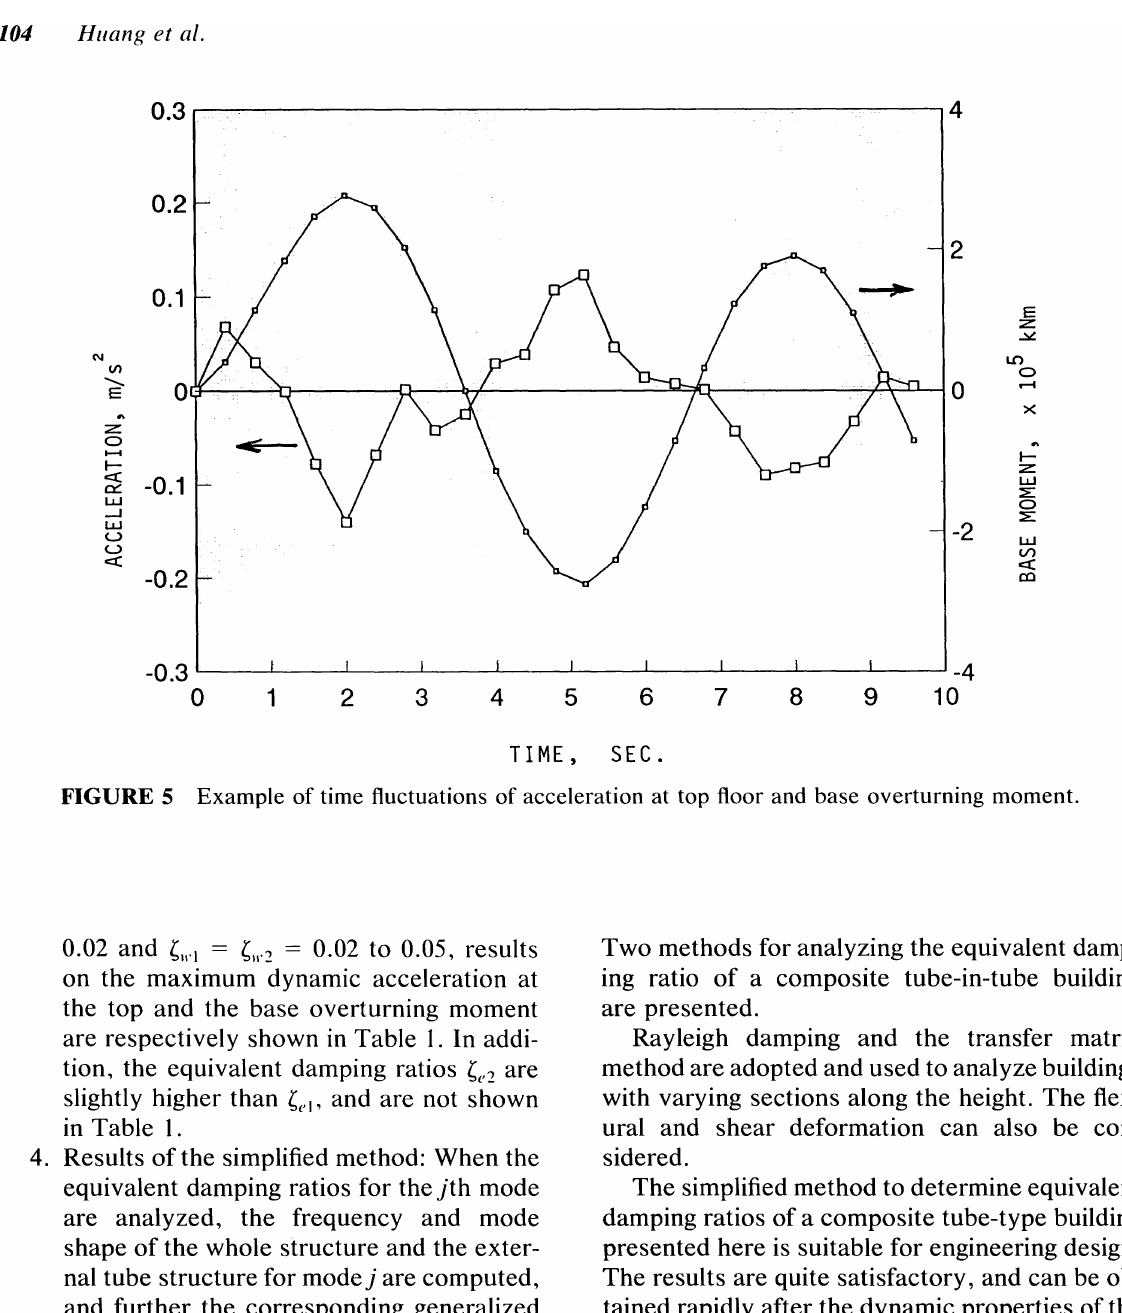
0.02 and ~I\'I = ~1\'2 = 0.02 to 0.05,